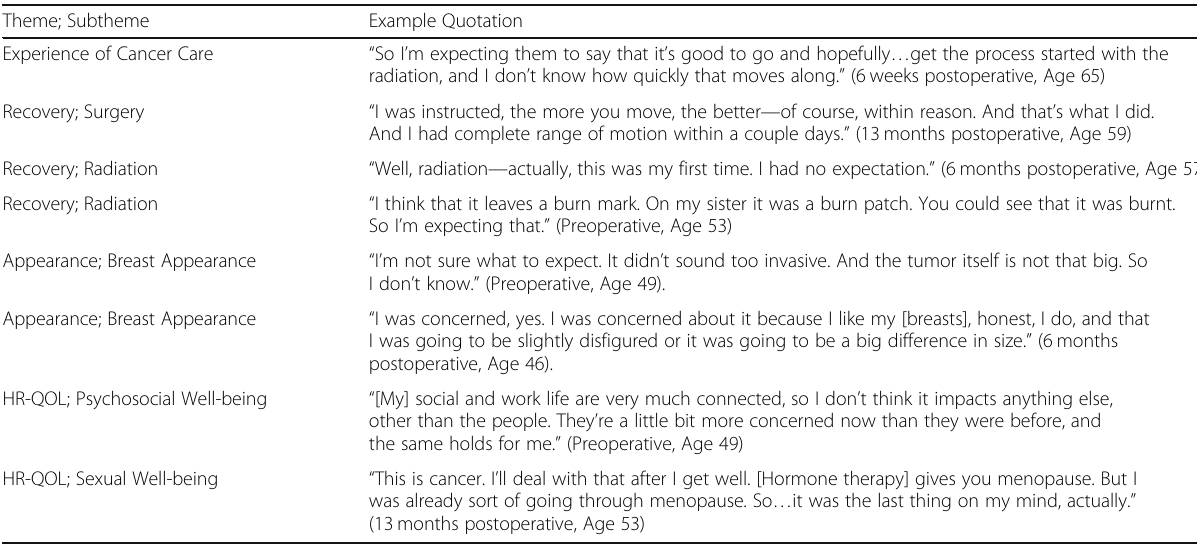
Table 2 Example quotations illustrating participant expectations of BCT Theme;